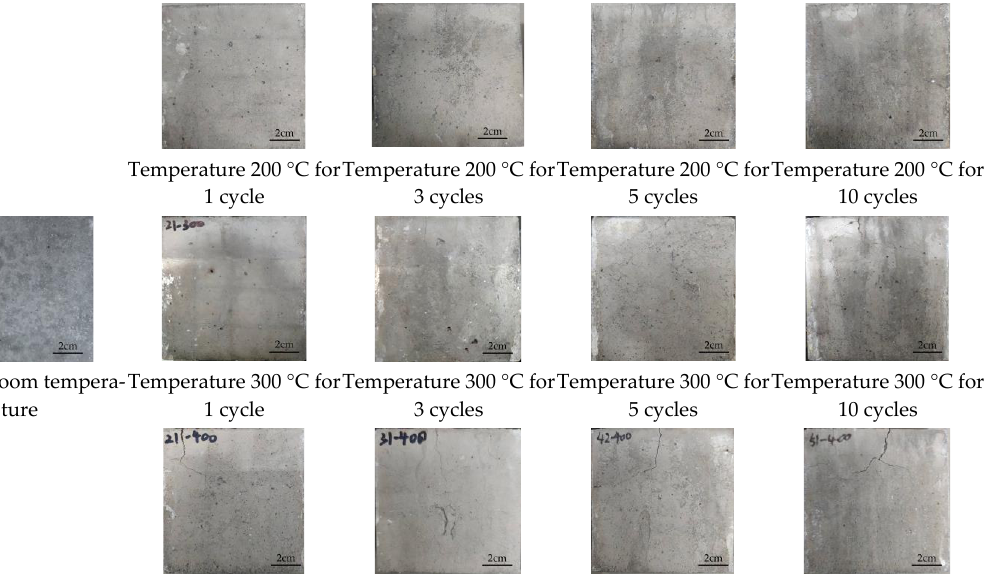
Figure 5. Apparent characteristics of magnetite concrete at high temperature with repeated heat- ing.